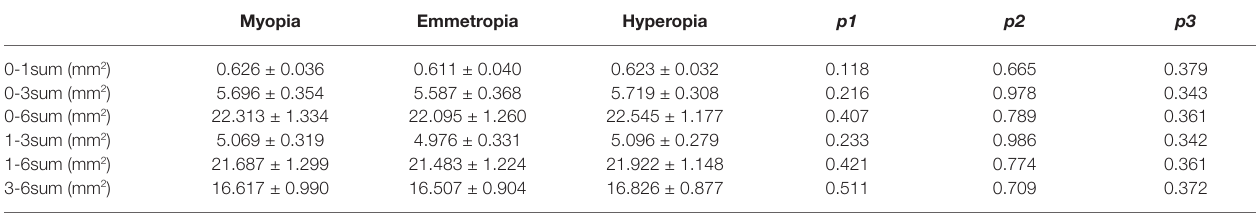
TABLE 4 | Baseline choriocapillaris luminal area (CLA) comparisons among myopia, emmetropia, and hyperopia groups. Myopia Emmetropia